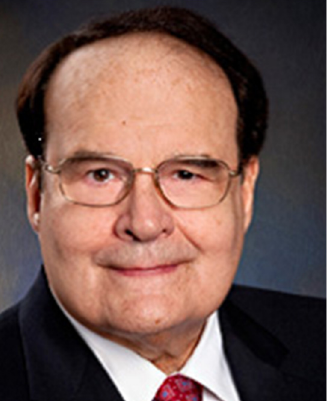
Figure 1. The Photo of Prof. Dr. Martin C. Mihm, Jr.